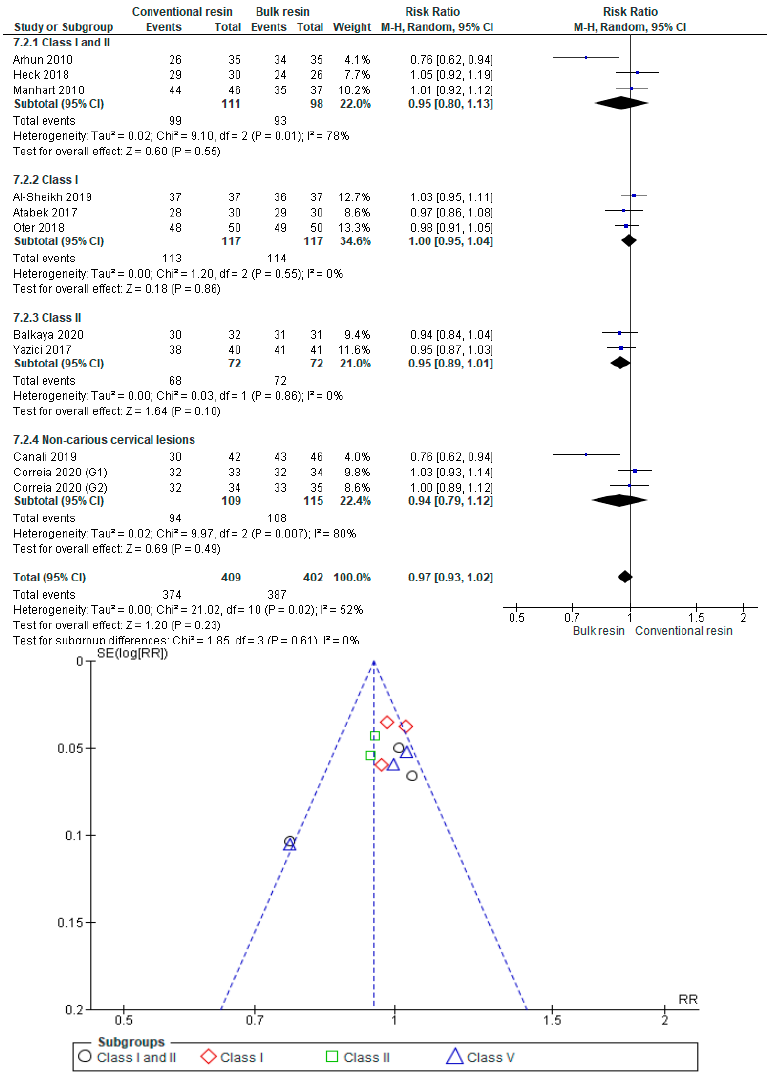
Figure A32. Proper Surface Texture: Conventional Resin versus Bulk Resin According to Type of Restoration.